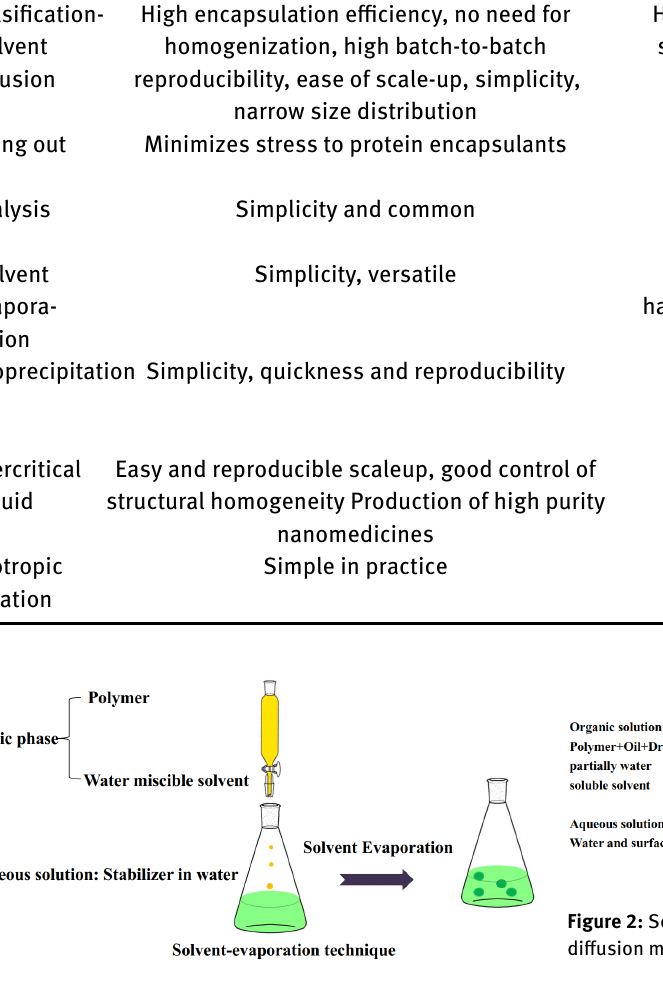
Figure 1: Schematic representation of the solvent-evaporation technique for the production of nanoparticles room temperature or under reduced pressure [25]. After